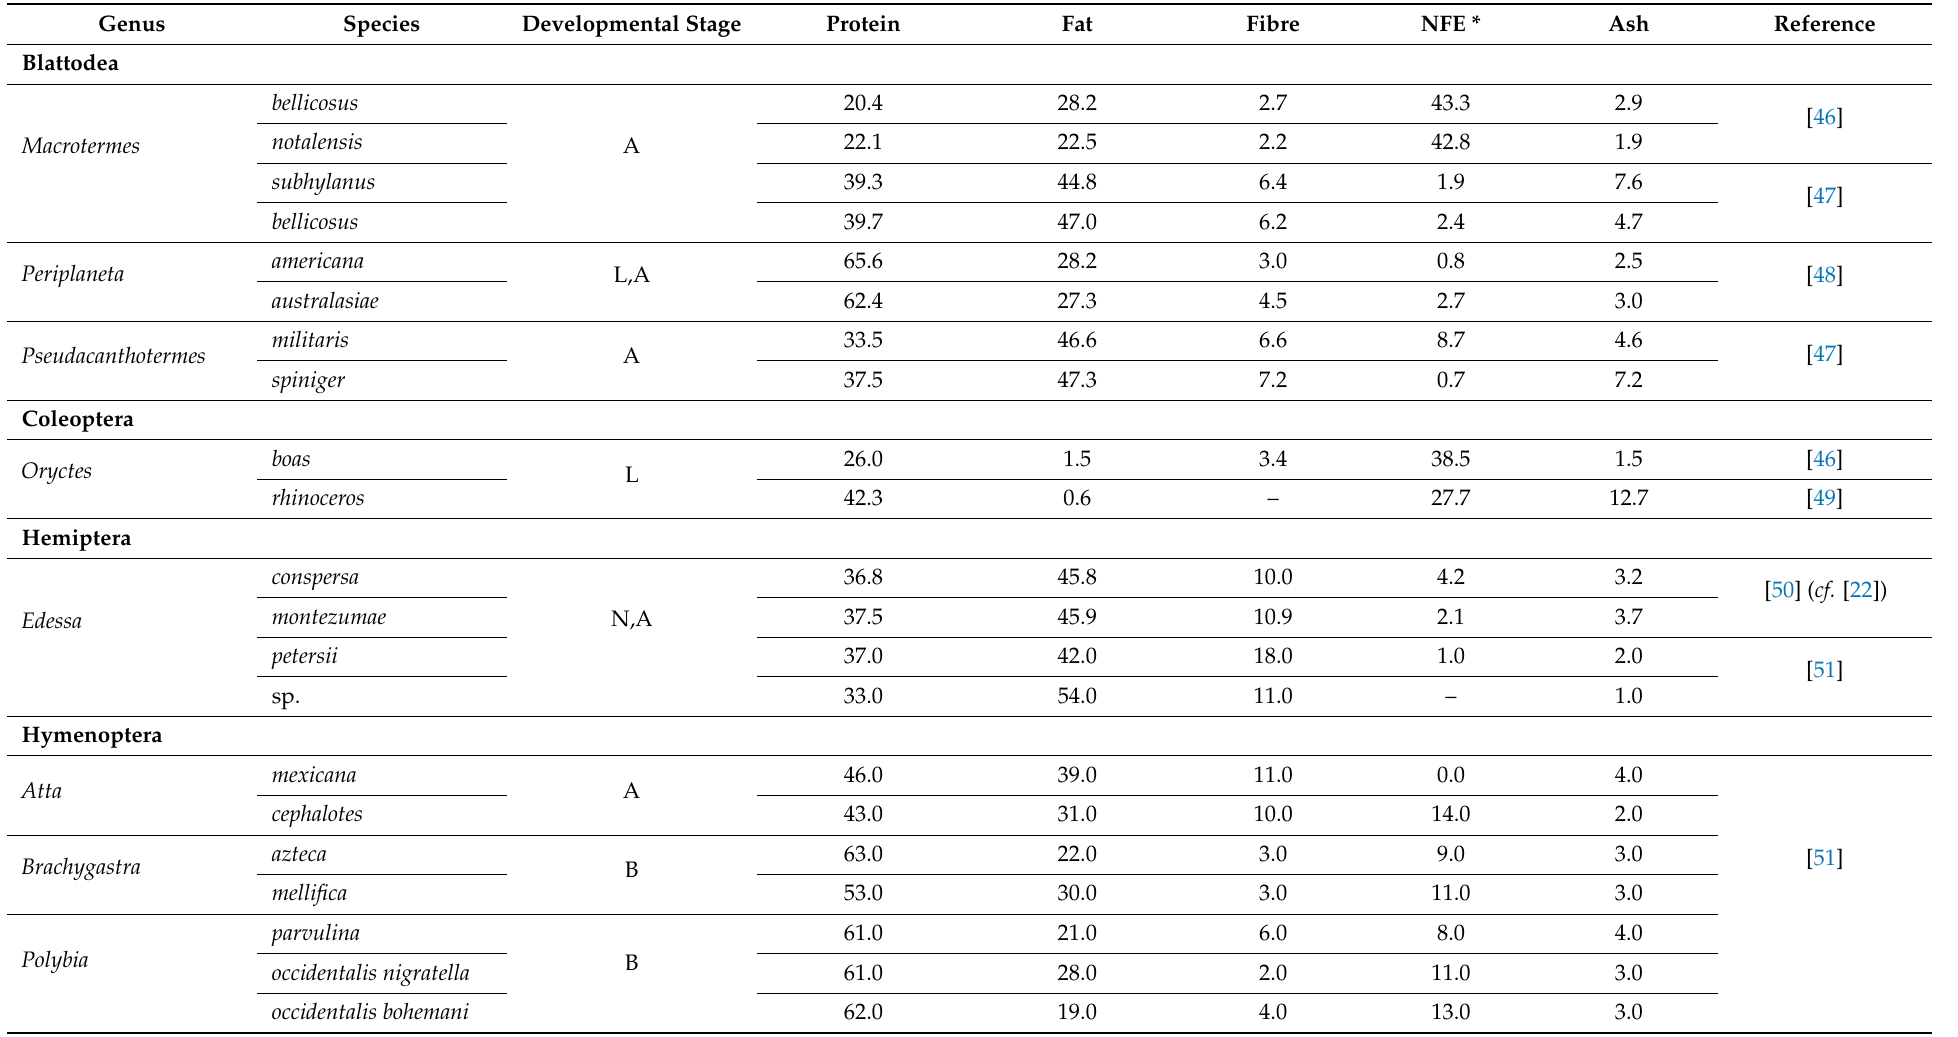
Table 2. Comparative account of proximate nutrient content (g/100g dry matter basis) of different species belonging to same genus. Genus Species Developmental Stage Protein Fat Fibre NFE * Ash